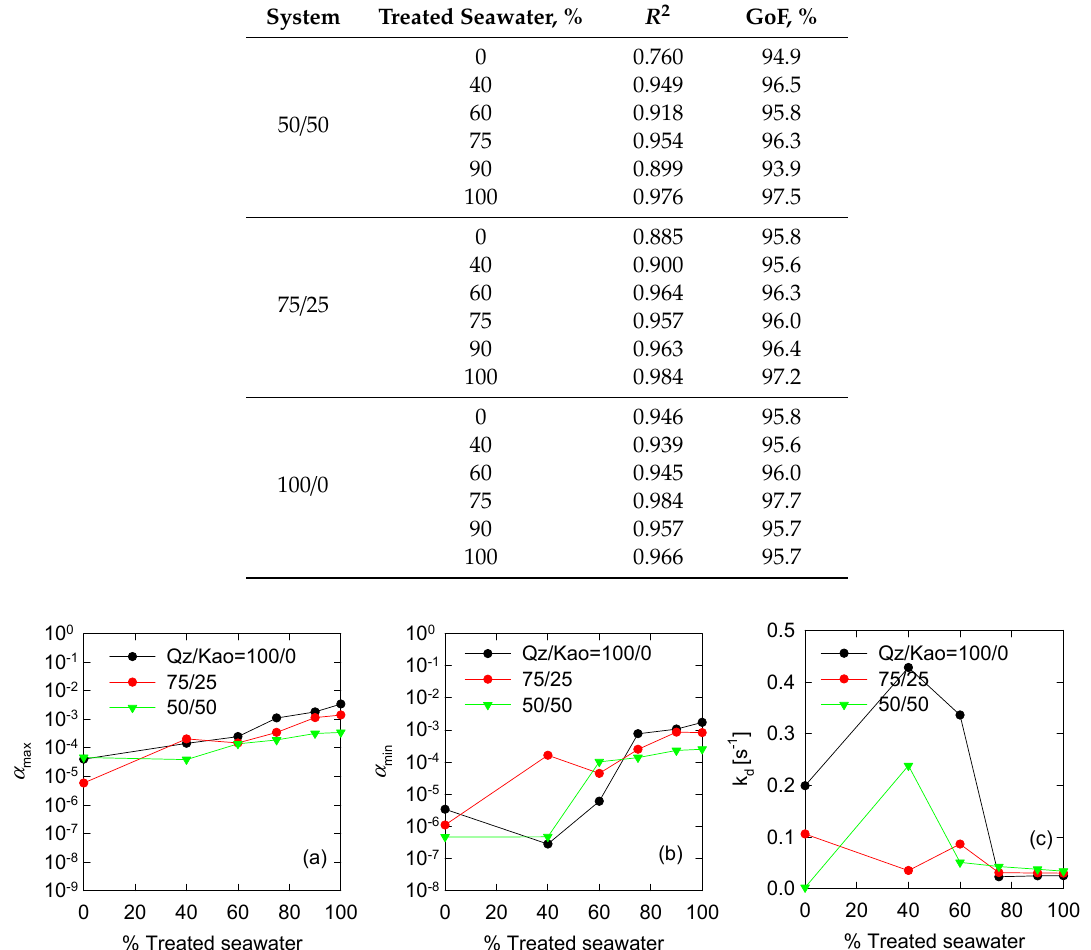
Table 3. Quantitative results of GoF and R 2 when the PBM model is used.